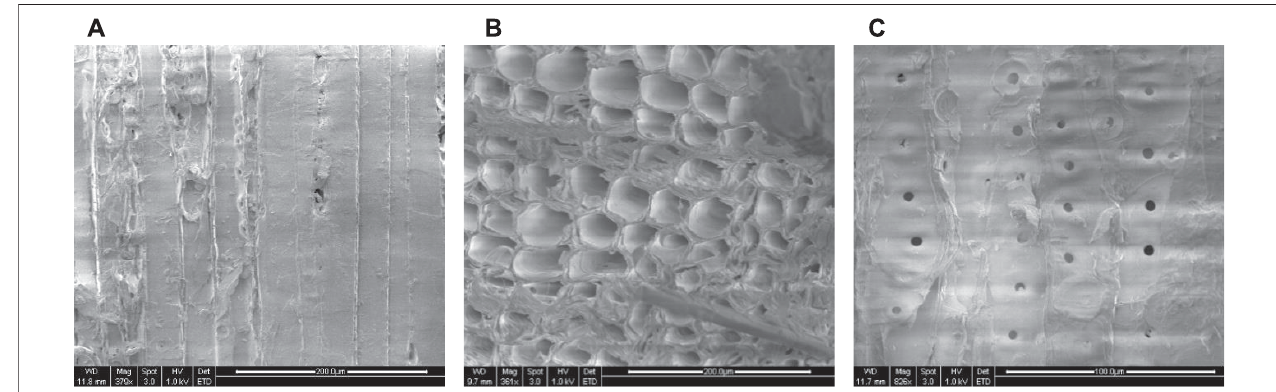
FIGURE 7 | SEM micrograph of a pine particle: (A) side view, (B) cross-sectional view, and (C) angular side.